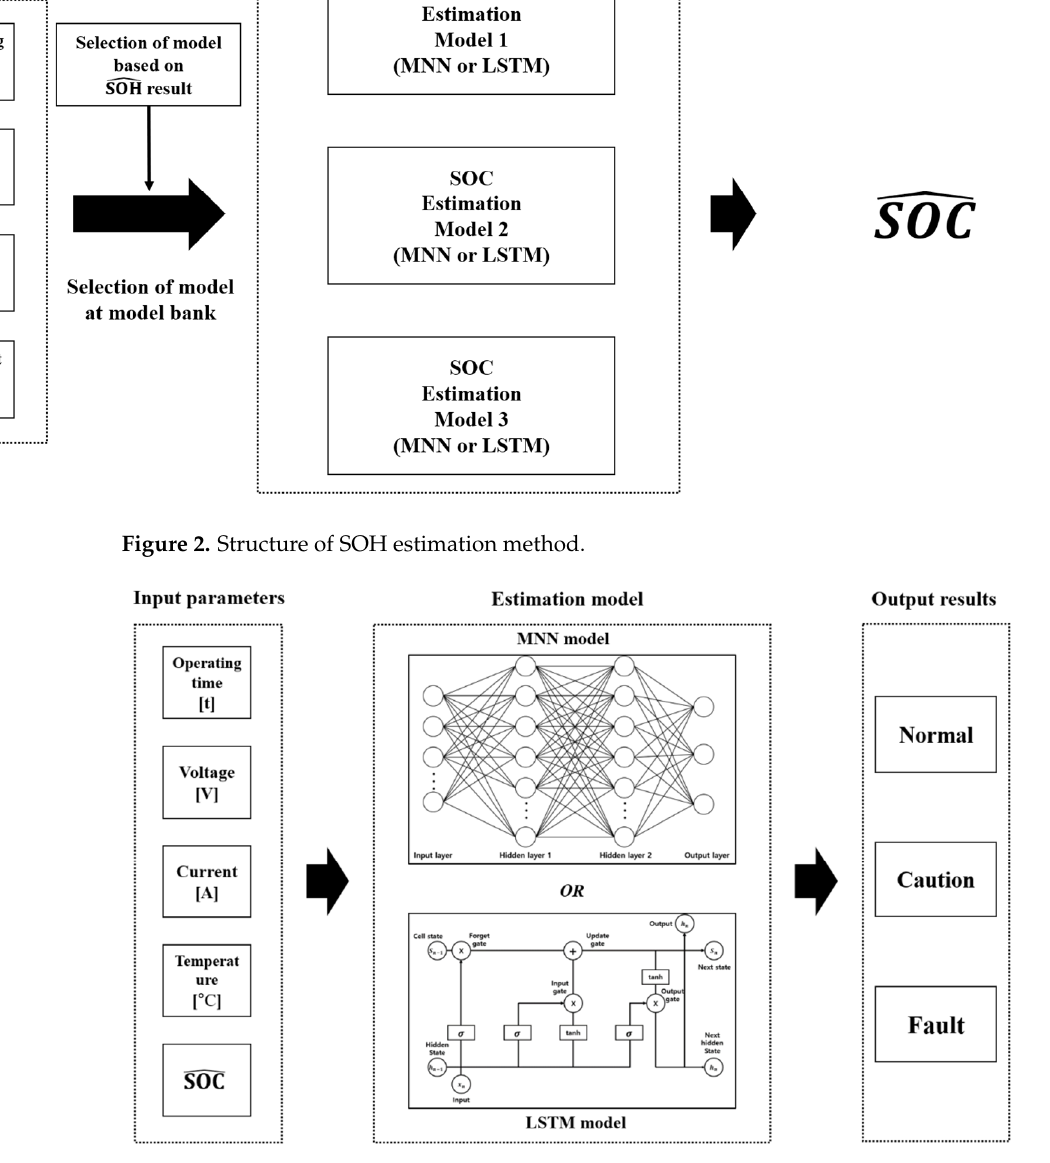
Figure 4. Process of proposed SOC and SOH estimation without a neural network model bank. Proposed Method 2: SOC Estimation with a Neural Network Model Bank Figure 5 shows a schematic illustrating the process of estimating the SOC and SOH using Method 2. This process involves four steps. In Step 1, the battery parameters are input into the neural network model bank for SOC estimation, and the average SOC is calculated using the output. This average SOC is used as the initial SOC, and this step is performed only once during algorithm execution. In Step 2, the SOC obtained in Step 1 is input into the SOH estimation model along with the battery parameters. The SOH estima- tion model outputs one of three states—normal, caution, or fault—according to the esti- mated SOH. In Step 3, based on the estimated SOH, the model reflecting the current bat-